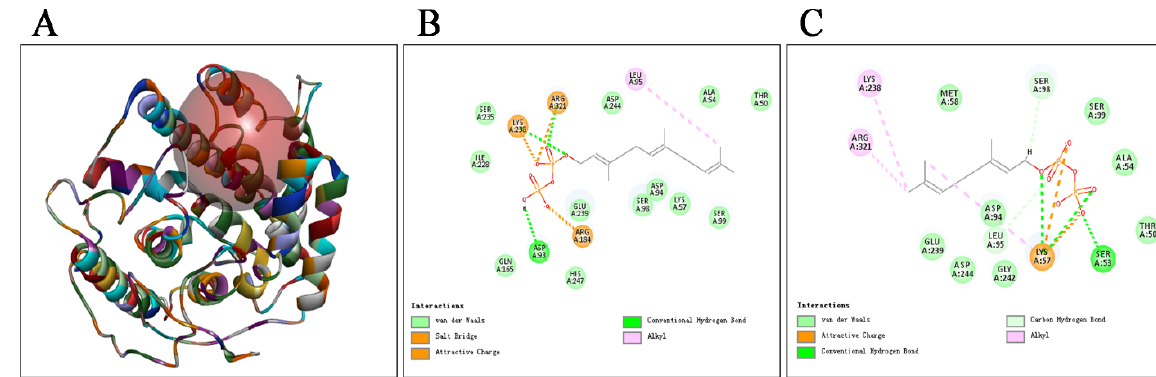
Figure 3. Structure model and molecular docking analysis of SmMTPSL19. ( A ) Three-dimensional model of SmMTPSL19. ( B ) Two-dimensional plan of SmMTPSL19 docking with farnesyl diphosphate (FPP). ( C ) Two-dimensional plan of SmMTPSL19 docking with geranyl diphosphate (GPP). The red circle represents the position of active pocket of receptor- ligand binding. The green dashed arrow represents the hydrogen bond between the atom on the main chain of the amino acid residue and the ligand. The pink dashed arrow represents the π-Alkyl interaction between the atom on the side chain of the amino acid residue and the ligand. The orange dashed line represents the π-Anion interaction force. The light green ellipse represents that amino acids and receptors form the van der Waals force.